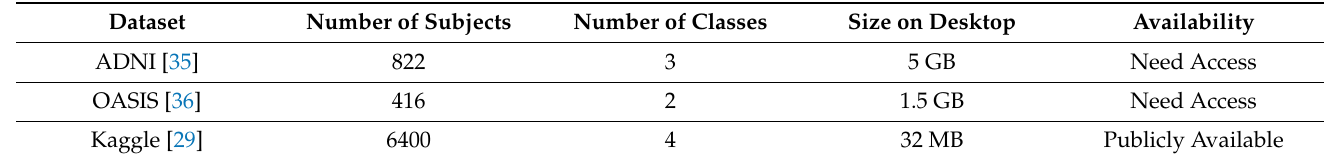
Table 3. Comparison between Kaggle dataset and other common datasets in this field.